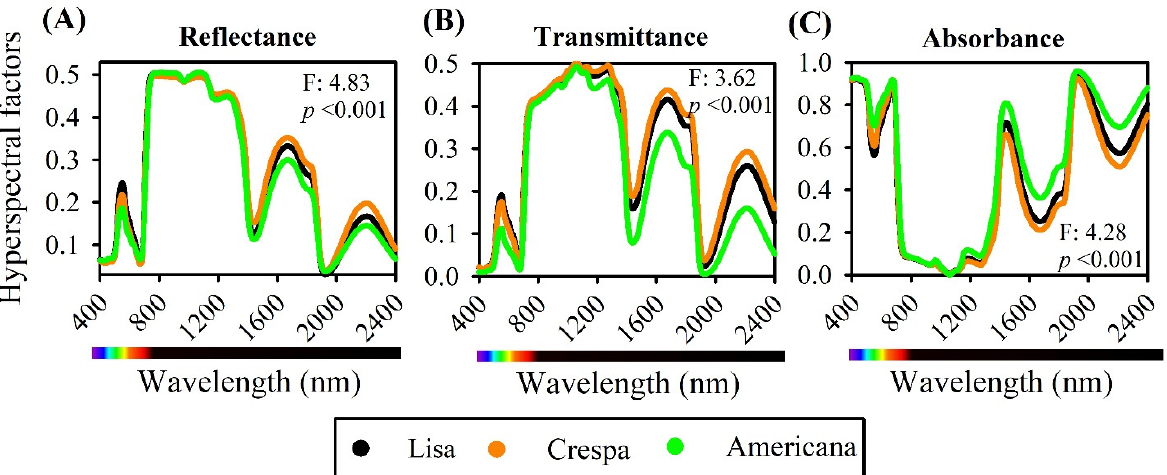
Figure 4. Average foliar hyperspectral factor profiles of fully expanded leaves of Lisa, Crespa, and Americana varieties of green lettuce. ( A ) Reflectance, ( B ) transmittance, and ( C ) absorbance of adaxial light source. F- and p -values from permutation analysis of variance (PERMANOVA) of full range (400–2400 nm) hyperspectral reflectance, transmittance, and absorbance of lettuce leaves reported in top-right or bottom-right corner of panel ( n = 600).